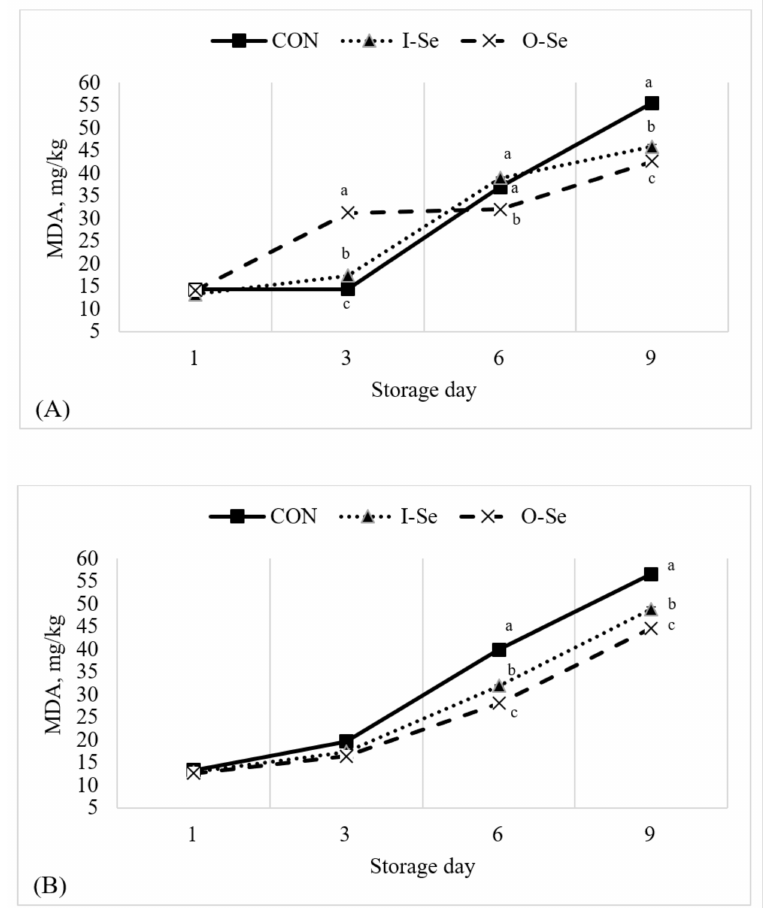
Figure 3. Effects of dietary supplementation with inorganic or organic selenium on the thiobarbituric acid reactive substances (TBARS) for goose meat (equal portions of the breast and thigh meat) ( A ) and liver ( B ) during 9 days of storage at 4 ◦ C. Treatments were defined as CON: basal diet without supplemental selenium; I-Se: basal diet with 0.3 mg/kg inorganic selenium; O-Se: basal diet with 0.3 mg/kg organic selenium. Means within the same day with differing letters are different ( p <